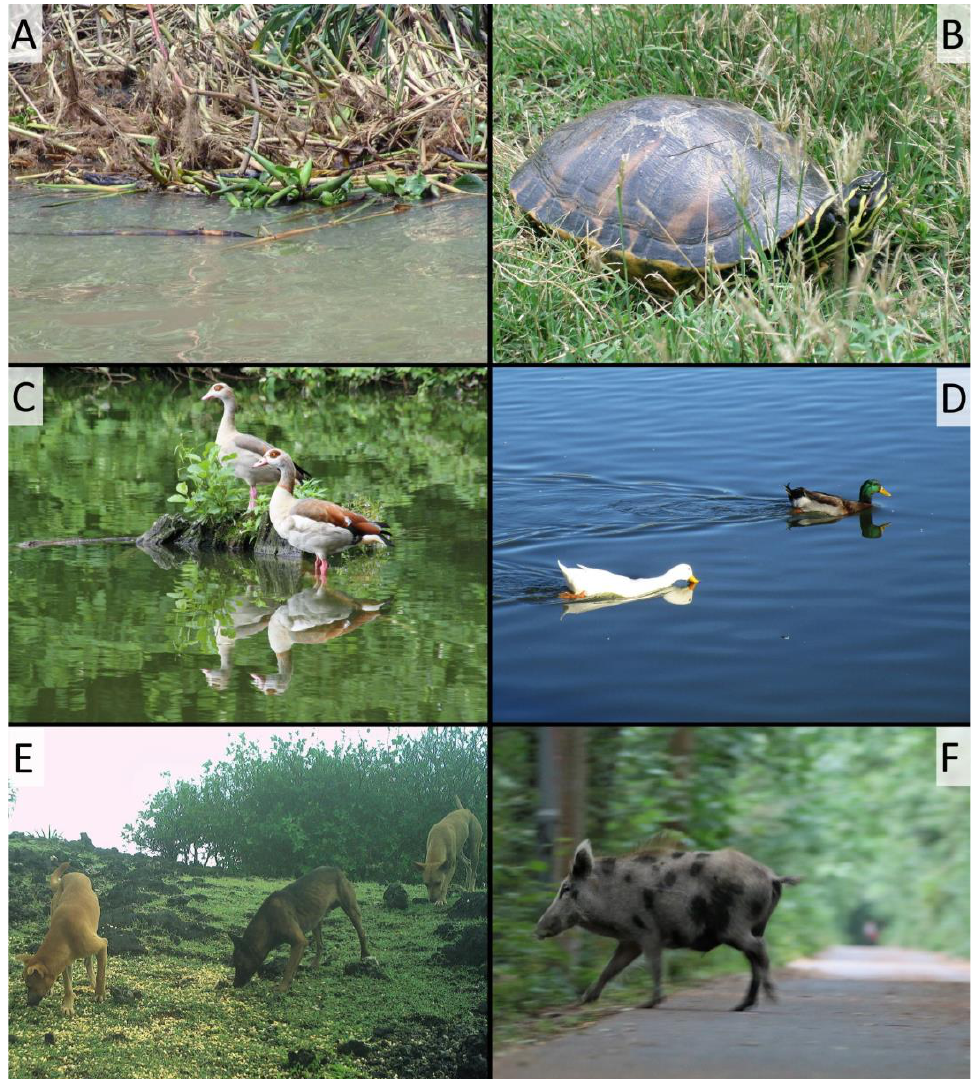
Figure 3. Selected examples of feral organisms from different parts of the world. ( A ): water hyacinth ( Eichhornia crassipes ) floating around at Lake Tana, Ethiopia; photo: G. Perry; ( B ): Florida red-bellied cooter ( Pseudemys nelsoni ), one of several found in the Road Town botanical garden pond, Tortola, British Virgin Islands; photo: G Perry; ( C ): Egyptian geese ( Alopochen aegyptiacus ) found at a pond in Saxony Anhalt, central Germany; photo: T. Göttert; ( D ): feral domestic ducks ( Anas platyrhynchos ) found at a water body in Lubbock, Texas, USA; photo: G. Perry; ( E ): feral dogs ( Canis lupus f. familiaris) photographed at a bait station near Yigo, Guam; photo: USDA-Wildlife Services Guam; ( F ): subadult wild boar ( Sus scrofa ) photographed in the city of Berlin, Germany and showing the characteristic coat color pattern of domestic pigs; photo: T. Göttert.